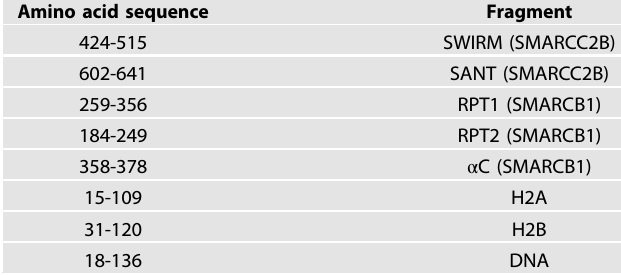
Table 1. Amino acid sequence corresponding to each